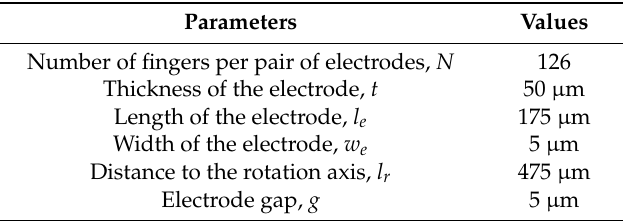
Figure 2. Linearization between electrostatic torque and driving voltage (V-linearization) for the slow axis: ( a ) initial position ( V d = 0), ( b ) rotated position ( V d > 0), and ( c ) photograph of the microscanner with tilted stationary combs. Table 1. Dimensions of the comb electrodes in the microscanner.